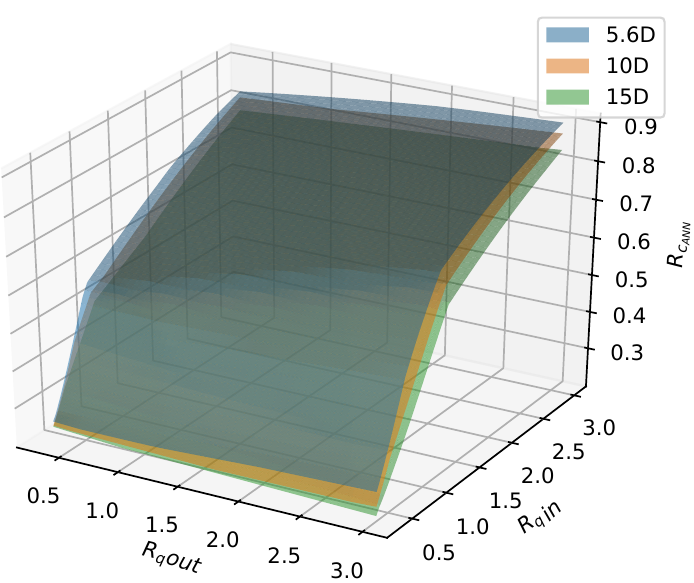
Figure 6. Predicted R c